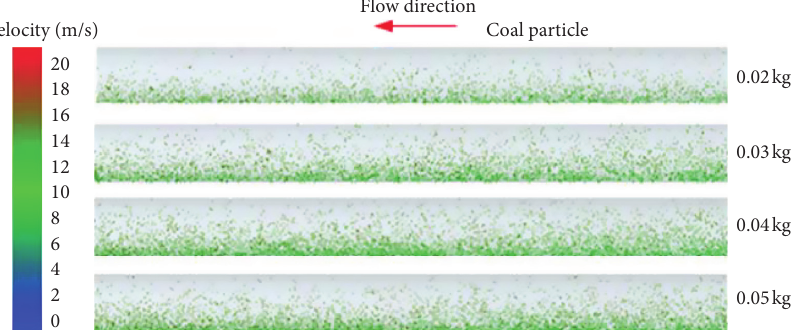
Figure 9: The coal-gas flow characteristic in drilling rod 4.5 ∼ 5.0m under gas velocity 25m/s ( t �